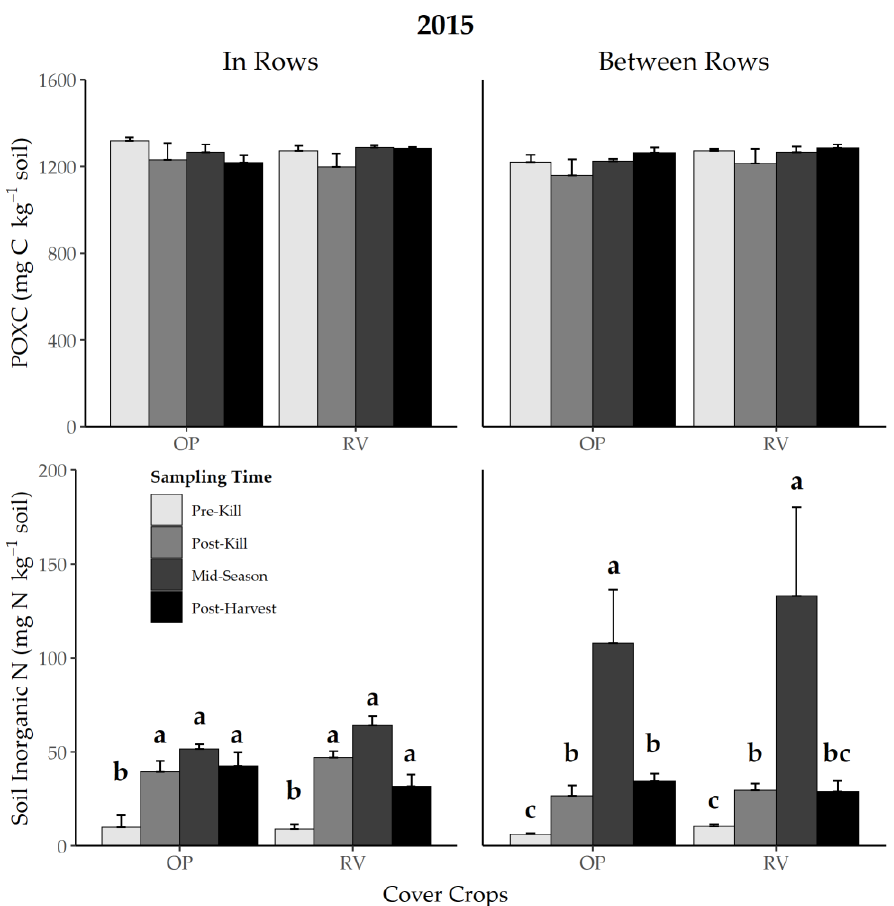
Figure 1. Effect of soil region and cover crop system on permanganate oxidizable C (POXC) and soil inorganic N in 2015 at four sampling times. Error bars represent one standard error. Different lowercase letters over bars within a cover crop system and soil region represent a difference between sampling times at p < 0.05. OP = oat + field pea, RV = winter rye + hairy vetch.